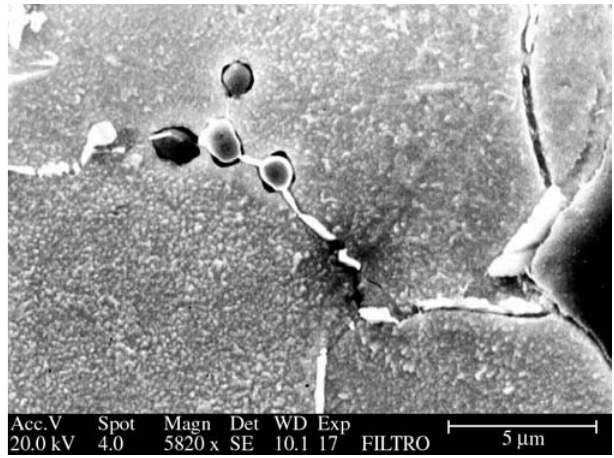
Figure 4. Scanning electron micrograph of filter prepared with powder in the size range 74-44 (cid:77) m and compacted at 400 MPa. Precipitates at the grain boundaries are chromium rich and the round particles are aluminum silicates.